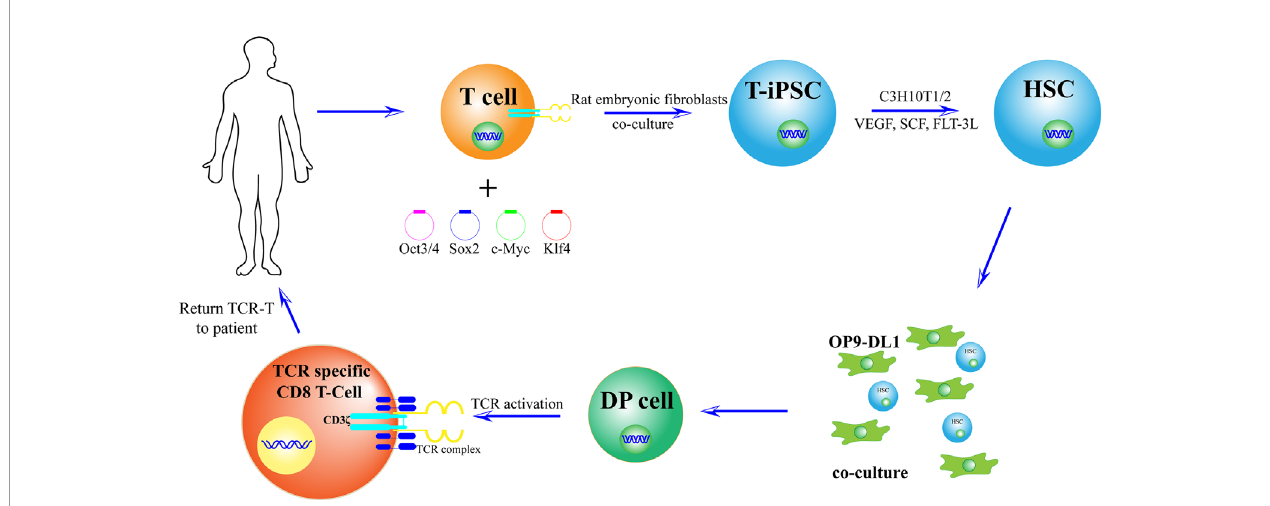
FIGURE 4 | Preparation of new antigen-speci fi c TCR-T cells. First, T cells with new antigen-speci fi c TCR rearrangement gene were isolated from the body. Second, after adding OCT3/4, Sox2, KLF4, and c-MYC, T cells were induced to T-iPSC. Third, in the presence of bone marrow mesenchymal stem cells (C3H10T1/2), vascular endothelial growth factor (VEGF), stem cell factor (SCF), and tyrosine kinase ligand 3 (FLT-3L), T-iPSCs were differentiated into mesodermal CD34+ hematopoietic stem cells (HSCs) and hematopoietic progenitor cells. Cells were transfected to OP9-DL1 FLT-3 and IL-7 culture medium to obtain T cell lineage. Thus, a large number of T cells will be used to recognize and kill tumor